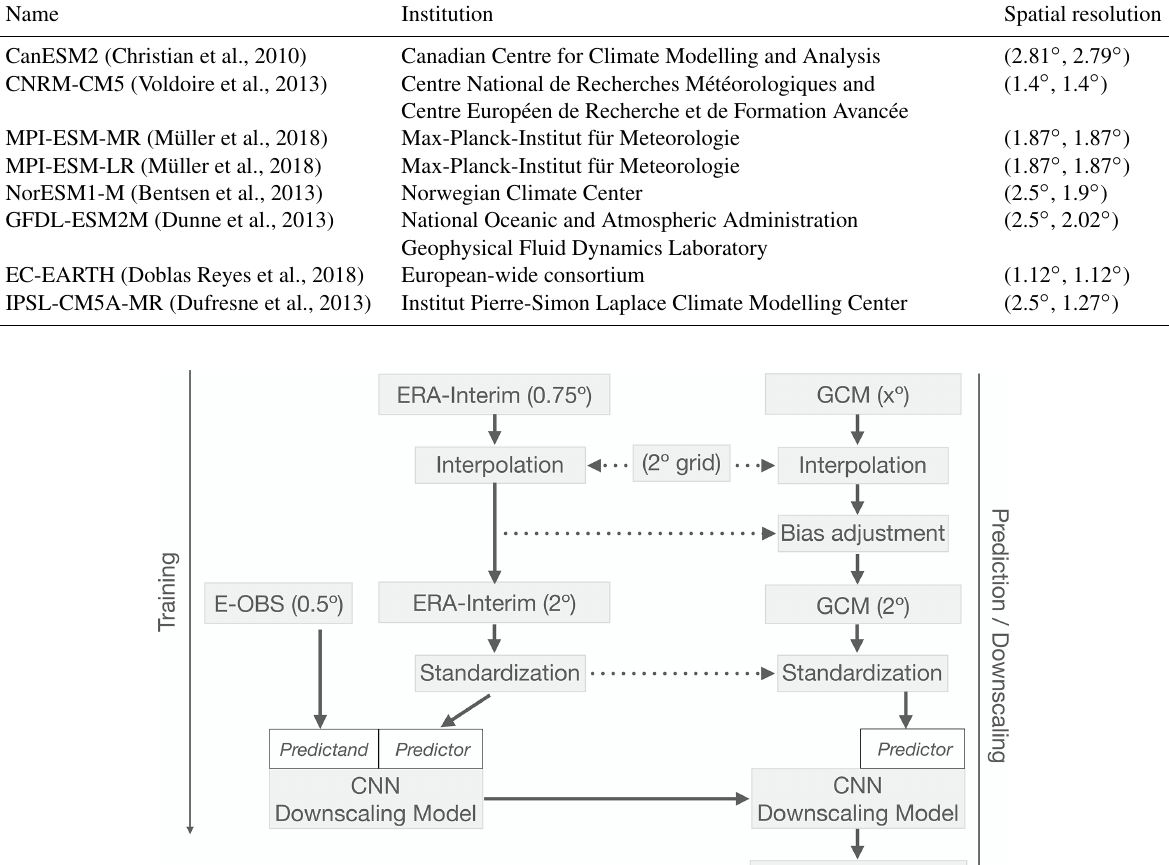
Table 1. The different CMIP5 models used in this study.